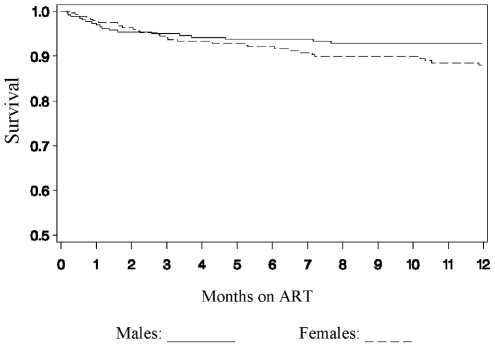
The gender-stratified Kaplan-Meier graph of survival after ART initiation.